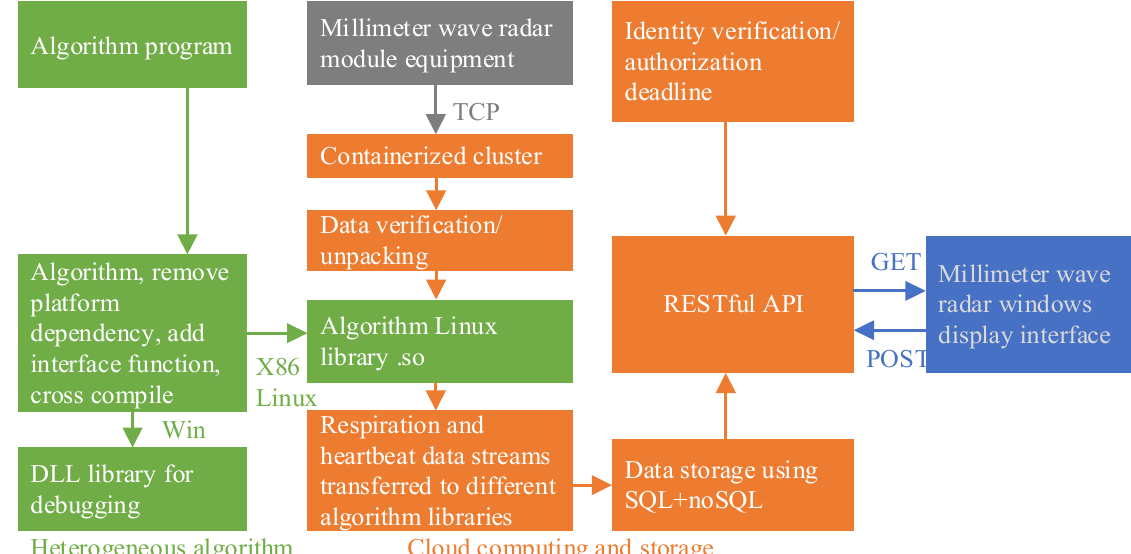
Figure 12. Software system architecture diagram based on cloud service.